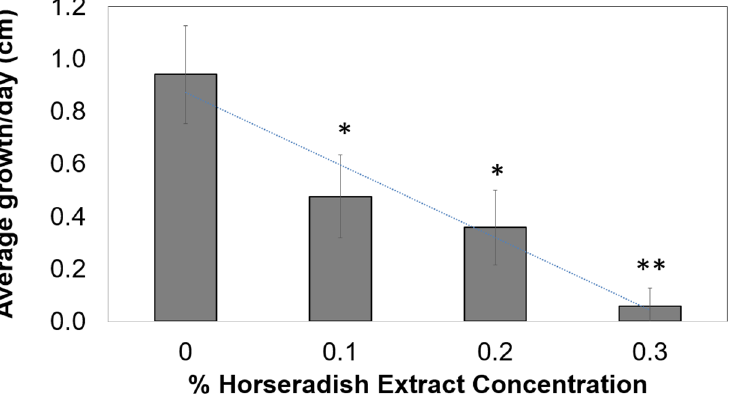
Figure 1. Average growth per day (cm) of onion root tips over 3 days during treatment with 0% control (without HRE) and solutions with 0.1%, 0.2%, and 0.3% concentrations of HRE. * and ** indicate significant difference from control by Student’s t -test at p = 0.05 and p = 0.01, respectively.